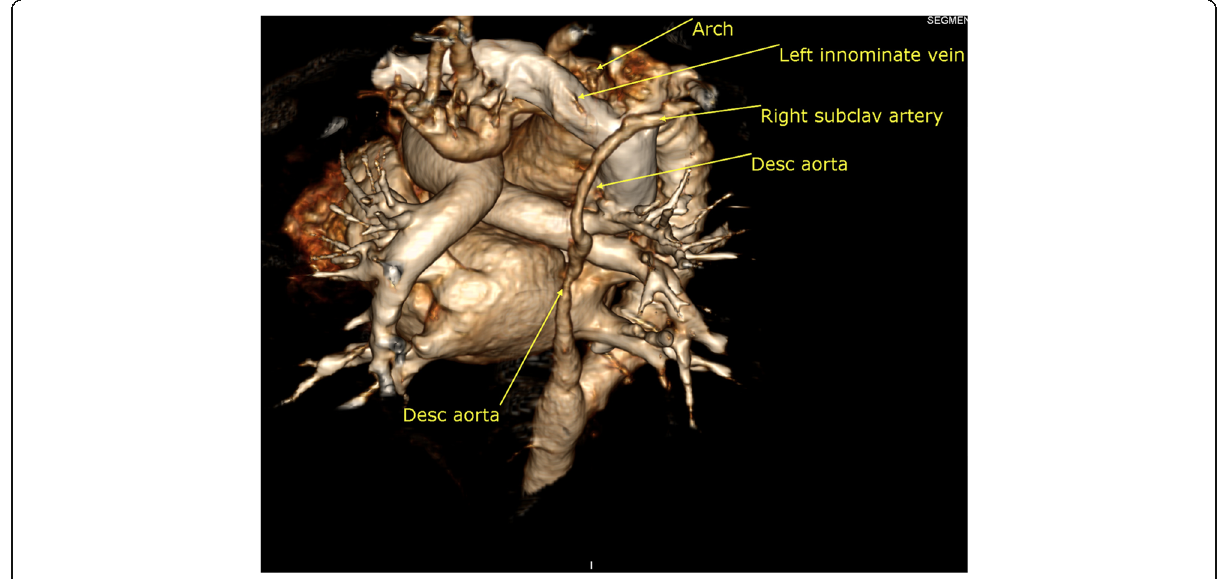
Fig. 2 3D MDCT volume rendering image shows the interruption segment and long segment of aortic